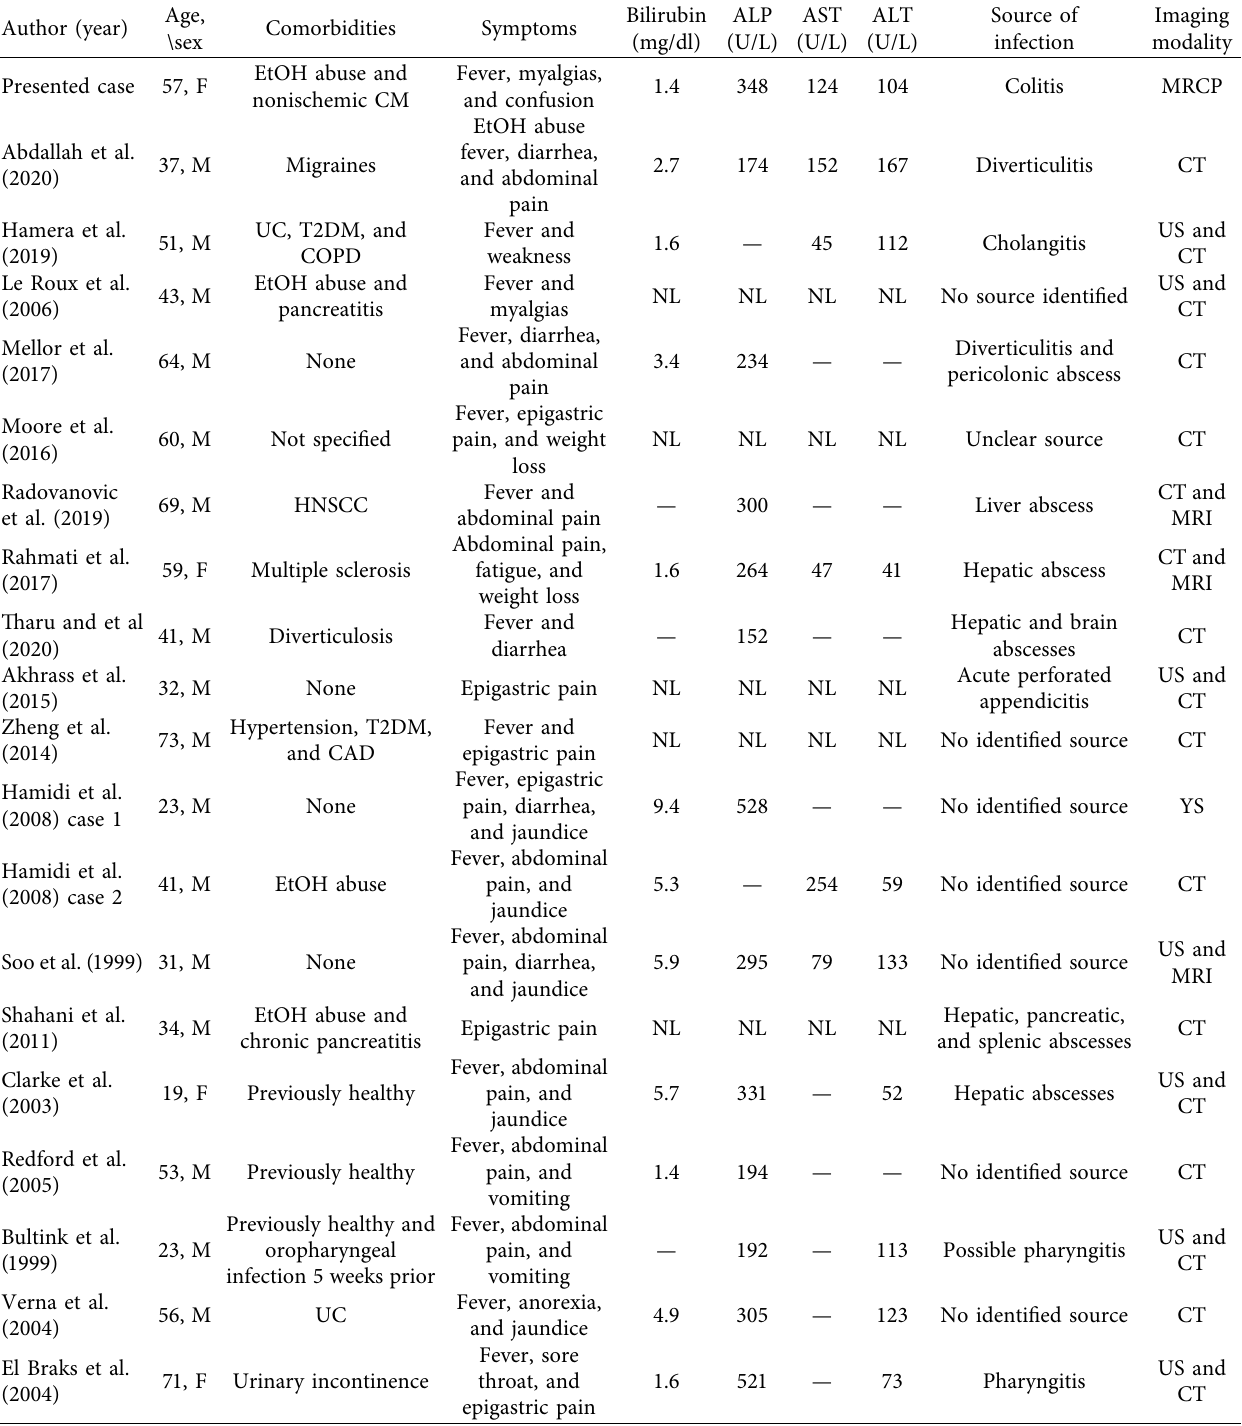
Table 1: Demographic and clinical characteristics and diagnostic imaging modalities in patients with Fusobacterium-spp. -associated